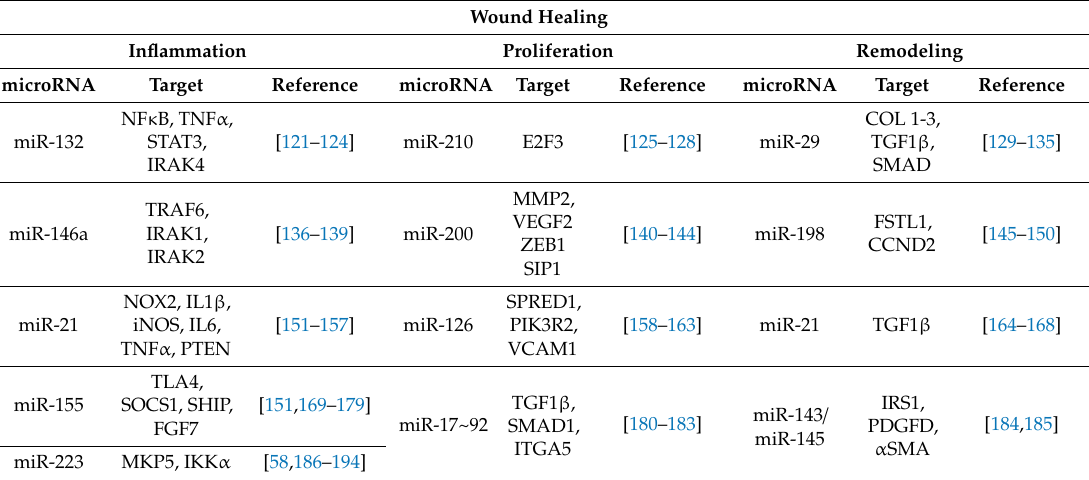
Table 2. microRNAs involved in di ff erent stages of wound